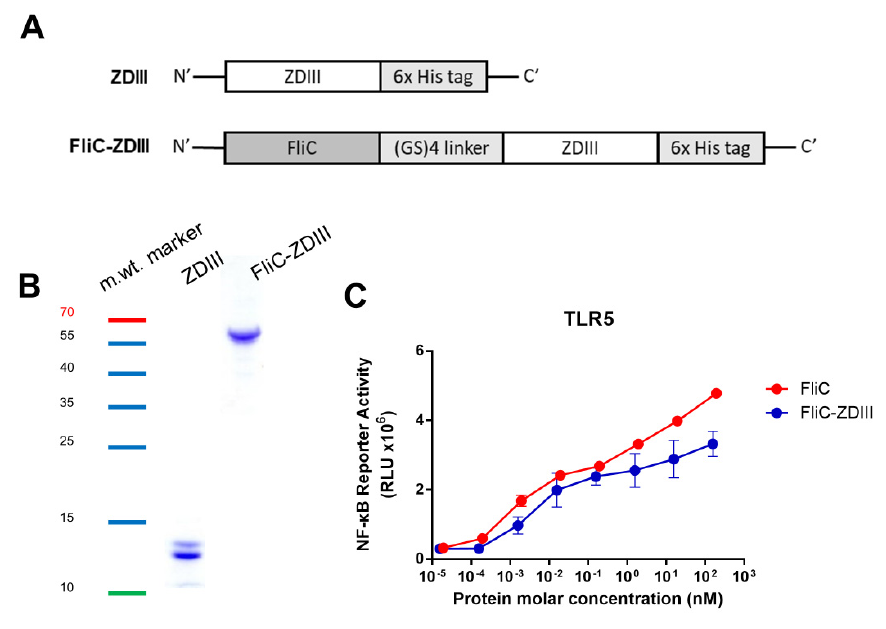
Figure 1. Expression and characterization of ZDIII and FliC ‐ ZDIII recombinant proteins. ( A ) ZDIII and FliC ‐ ZDIII, which were linked by a (GS) into the pET ‐ 22b (+) vector with a C ‐ terminal His ‐ tag for recombinant protein expression. ( B ) ZDIII